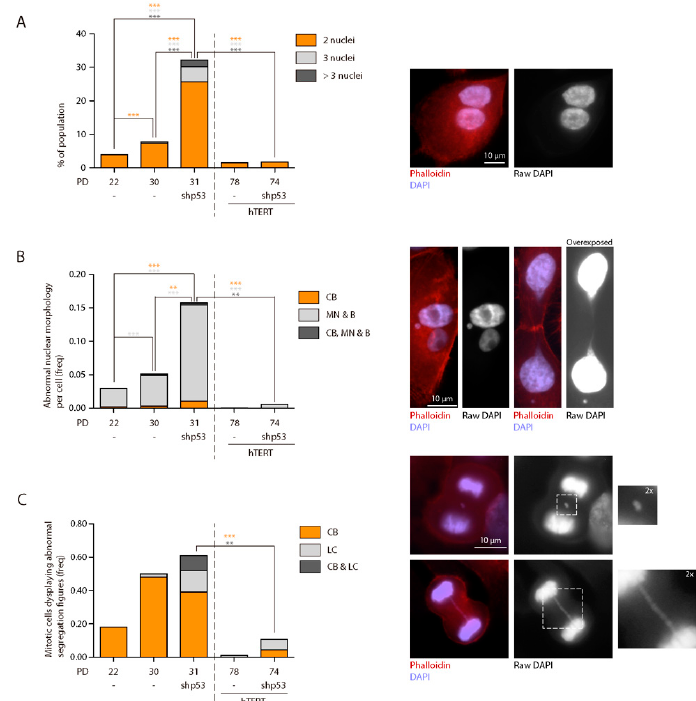
Figure 5. Analysis of abnormal morphologies in vHMEC derivatives. ( A ) Graph showing the percentage of binucleated, trinucleated cells and cells with more than three nuclei in interphase vHMECs. Finite vHMECs showed a significant increase in binucleation with increasing telomere attrition, and this effect was exacerbated when p53 was compromised. Representative images of a binucleated cell are shown. Scale bar corresponds to 10 µm; ( B ) Analysis of abnormal nuclear morphologies, i.e., chromatin bridges (CB), nuclear buds (B) and micronuclei (MN) among the different cell lines. Micronuclei and buds were the most frequent aberrations in vHMECs suffering telomere-dysfunction, followed by chromatin bridges. These aberrations were extremely abundant when p53 was compromised in finite vHMECs. Representative images of interphase cells displaying abnormal nuclear morphologies are shown. Scale bar corresponds to 10 µm; ( C ) Abnormal segregating figures were also observed in mitotic cells. In particular, chromatin bridges (CB) were abundant in those cells showing telomere-dysfunction. Likewise, those cells deficient for p53 were more prone to display lagging chromatin (LC). Representative images of abnormal anatelophases are shown. Scale bar corresponds to 10 µm. In the three graphs, statistical significance after Fisher’s exact test comparisons is shown with asterisks in the same colour code as the legend. Only p -values lower than 0.0125 after Bonferroni p -value correction, were considered significant. ** indicates p -values lower than 0.01; *** indicates p -values lower than